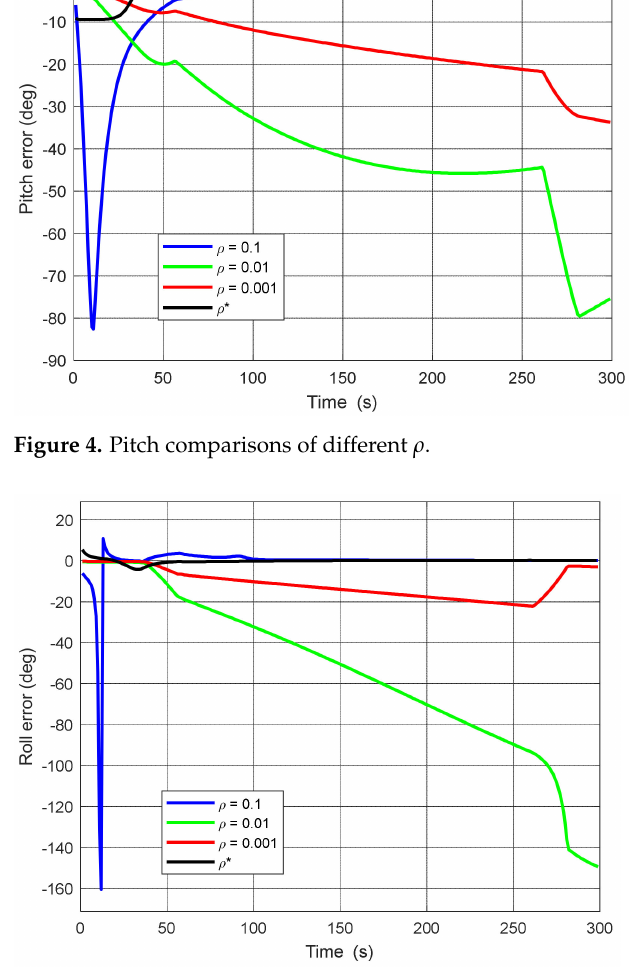
Figure 5. Roll comparisons of different ρ .